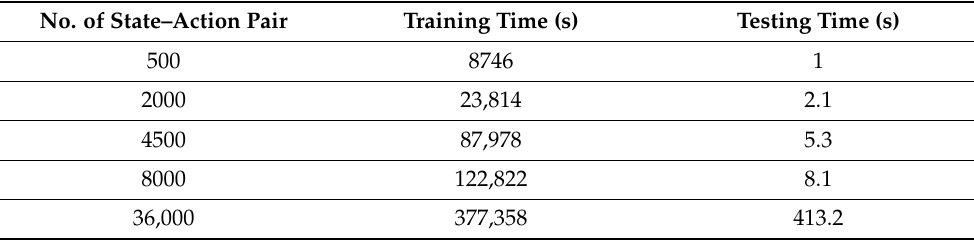
Table 9. The agent performance with different action–state configurations.